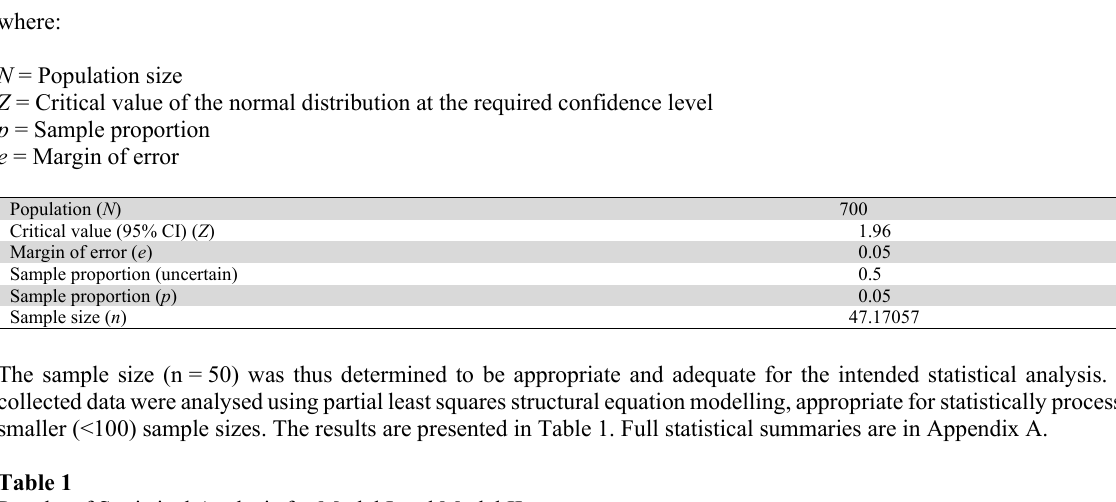
Results of Statistical Analysis for Model I and Model II Model I Model II Variable Unconstrained Constrained